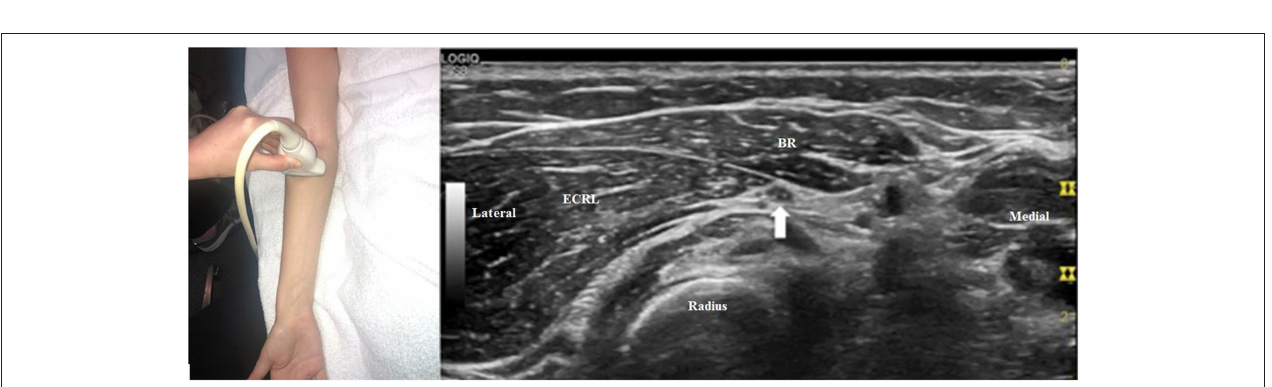
FIGURE 5 | The transducer is just distal to the antecubital fossa and the superficial radial sensory branch of the radial nerve can be seen (arrow). BR, brachioradialis; ECRL, extensor carpi radialis longus.